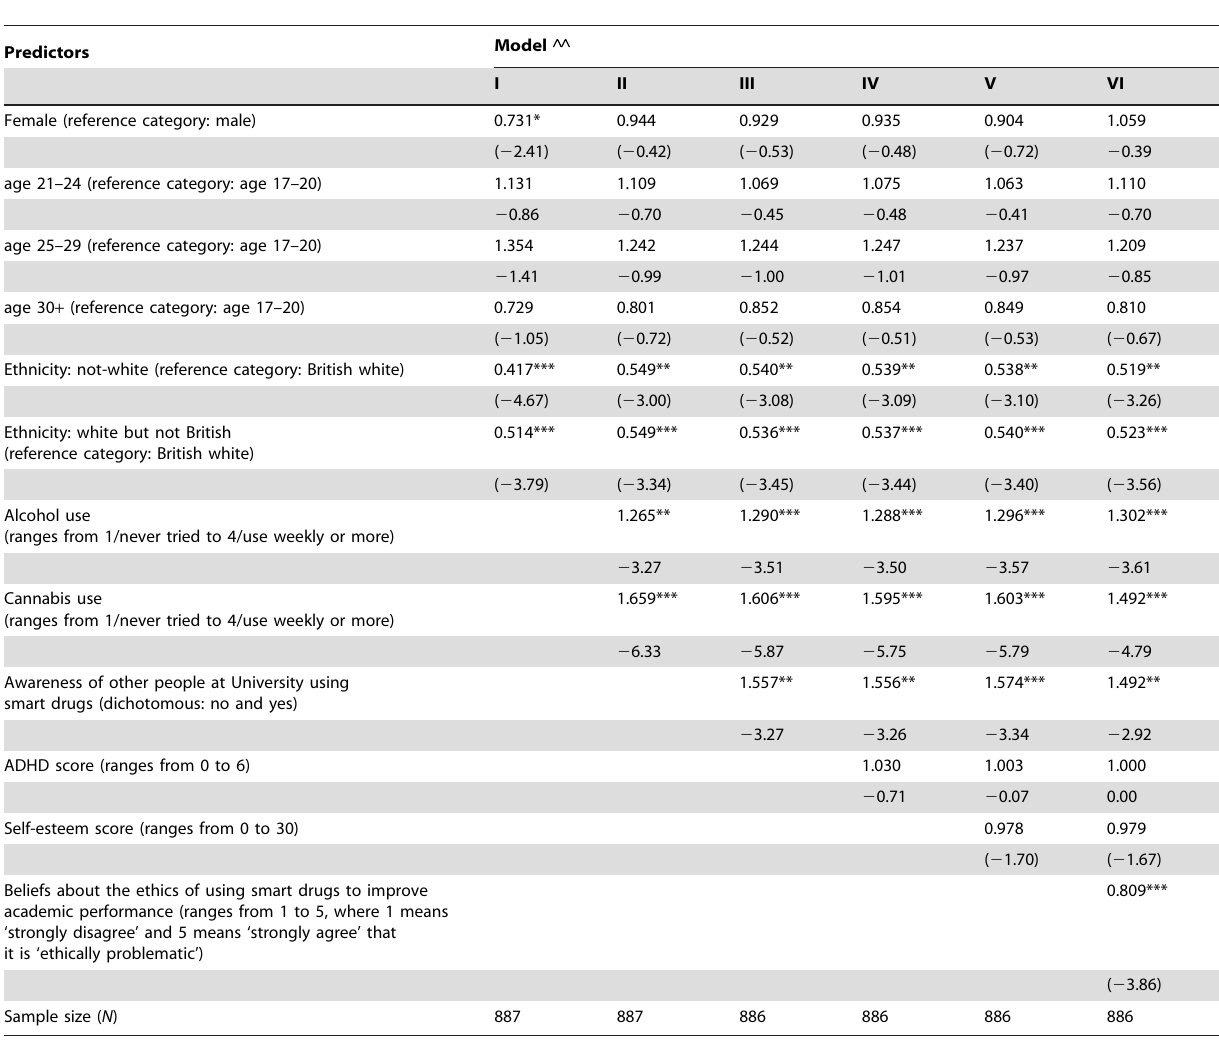
Table 13. Ordinal logistic regression predicting knowledge and usage of caffeine. +